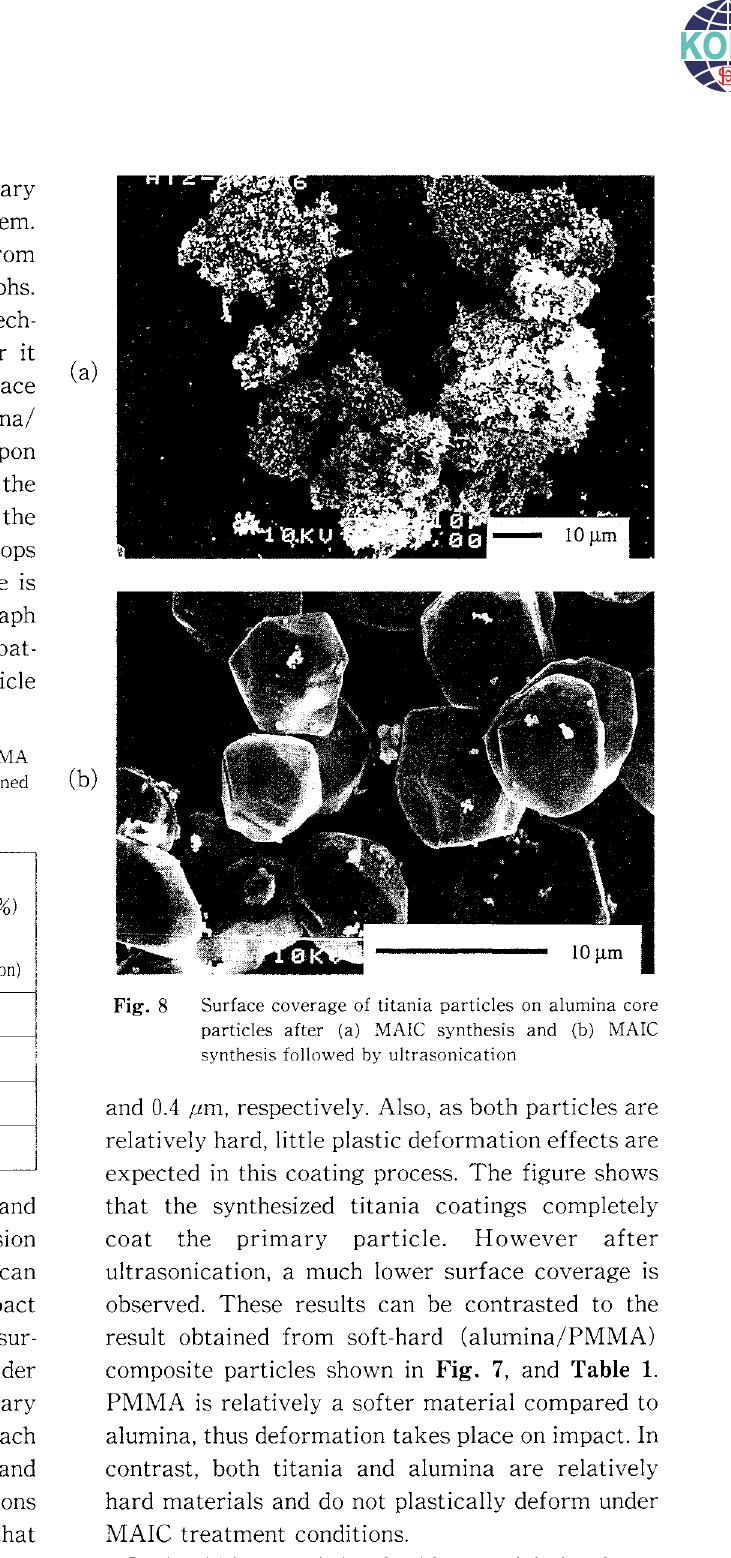
Fig. 8 Surface coverage of titania particles on alumina core particles after (a) :v!AIC synthesis and (b)